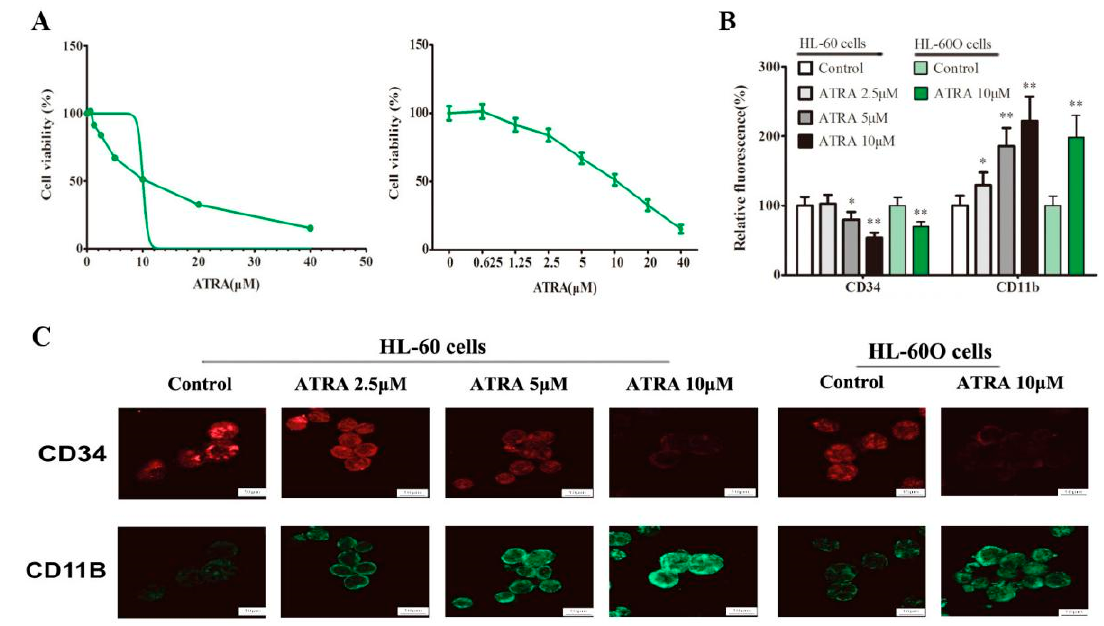
Figure 5. ATAR-induced HL-60 cell differentiation is associated with cytotoxicity. ( A ) ATAR decreases cell viability in a dose-dependent manner. ( B , C ) The expression of CD34 and CD11b was detected by immunofluorescence in HL-60 cells and in HL-60O cells. The data were presented as the mean ± SD ( n = 3). * p < 0.05; ** p < 0.01 compared to the untreated control.